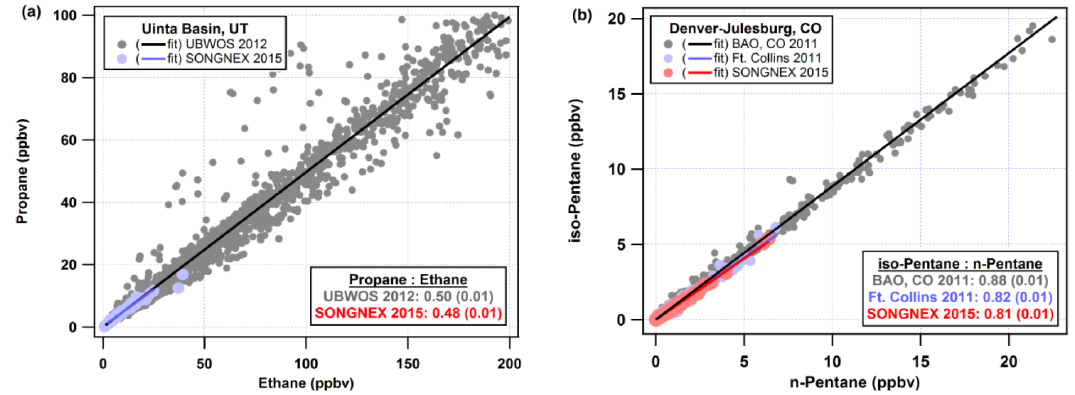
Figure 12. Intercomparison of alkane measurements made in oil and natural gas fields using a ground-based in situ GC-MS (Uinta Basin, UT (UBWOS 2012), Boulder Atmospheric Observatory (BAO; NACHTT 2011), Ft. Collins, CO (BIOCORN 2011)) and airborne WAS during SONGNEX